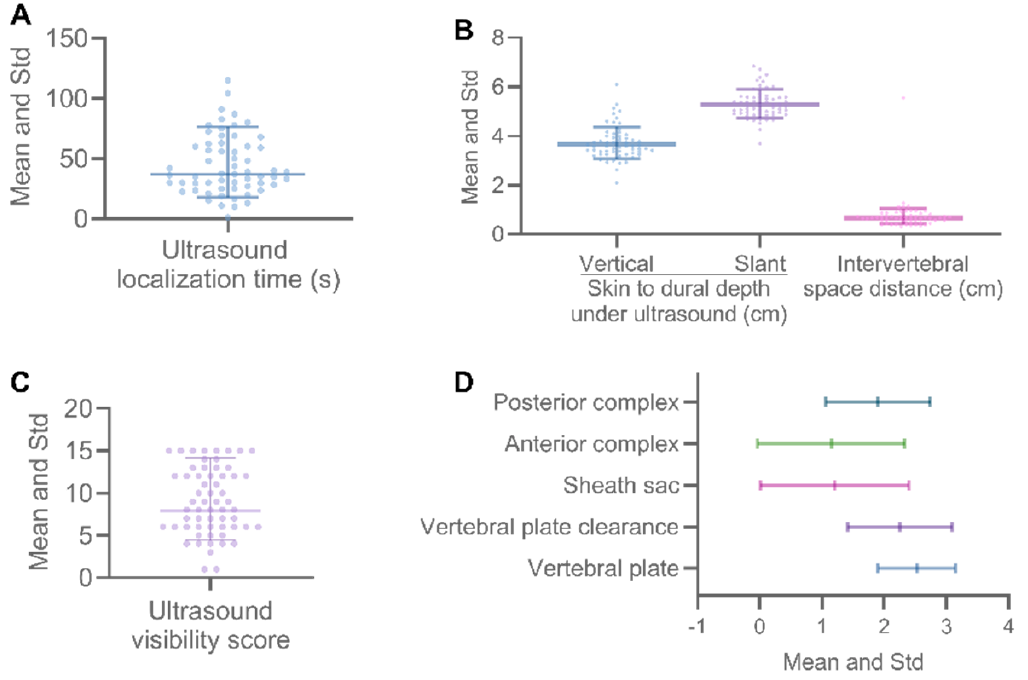
Figure 4. Quantitative measurements and ultrasound visibility score of neuraxial structures. The ultrasound localization time of all patients was under 2 min (120 s) ( A : ultrasound localization time (s)). The vertical distance from skin to dura measured by ultrasound was about 3.75 cm ( B , left), and the slope distance was about 5.62 cm ( B , right). Different transverse nerve structures were shown in different states under ultrasound ( D ), and the total UVS score ranged from 1 to 15 points ( C ). Abbreviation: % = percentage, Std = Standard deviation, s = second(s); cm = centime- ter(s).